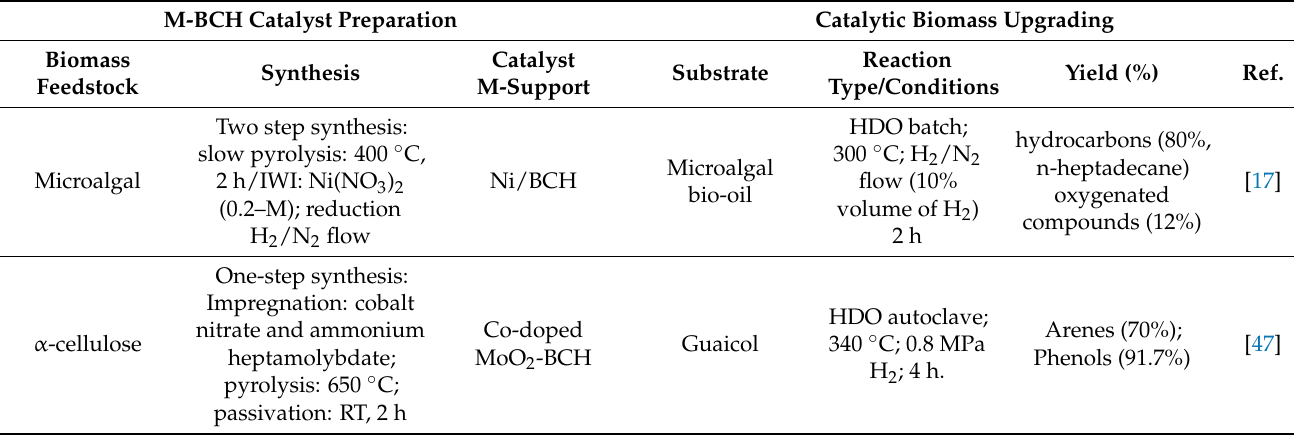
Table 2. Metal-supported biochar-based catalysts used in hydrogenation of biomass